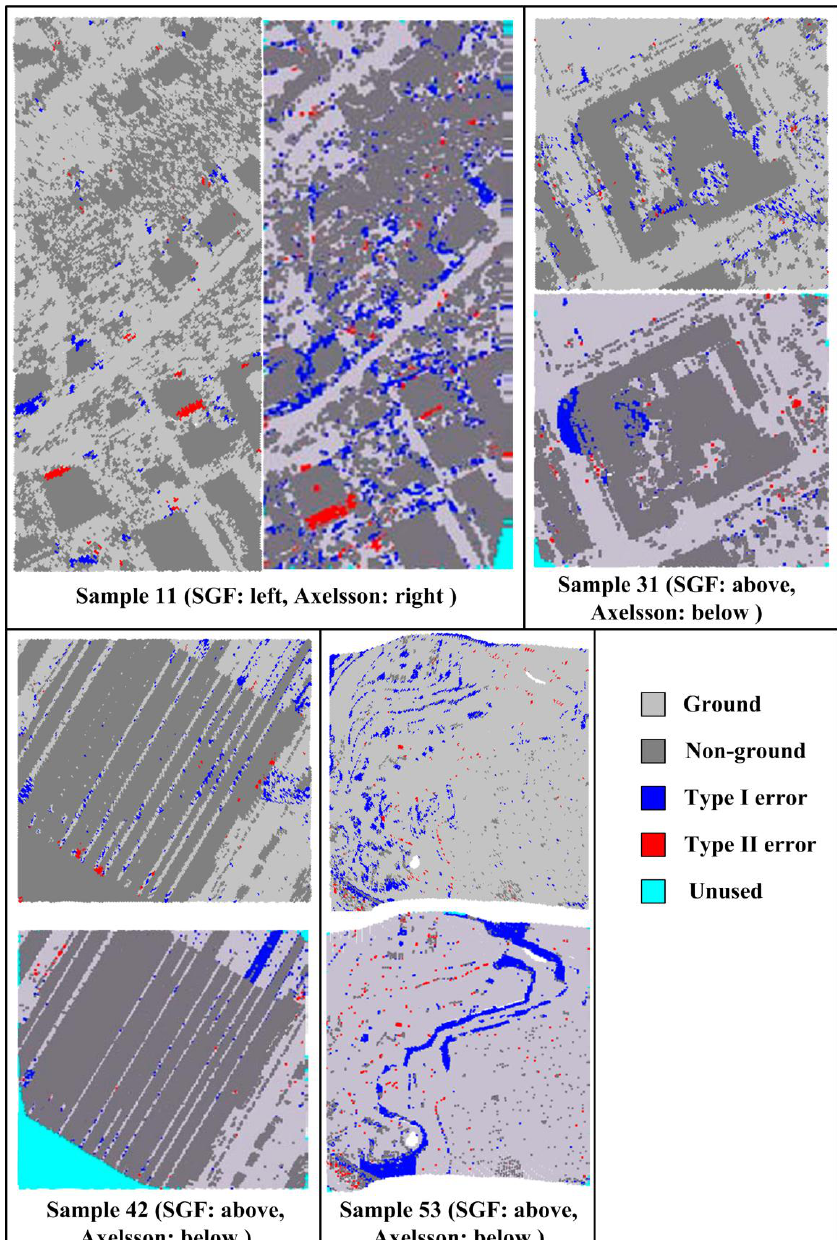
Figure 10. Error distribution of SGF and Axelsson’s algorithm on Sample11, Sample31, Sample 42, and